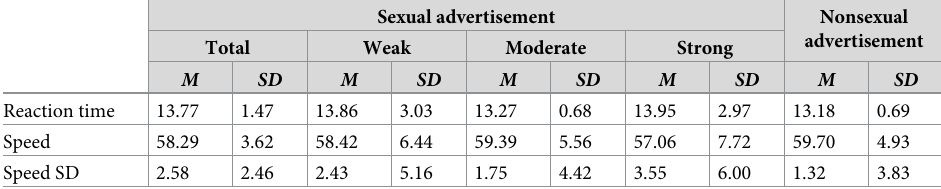
Table 4. Means and standard deviations for behavioral variables measured during the simulation